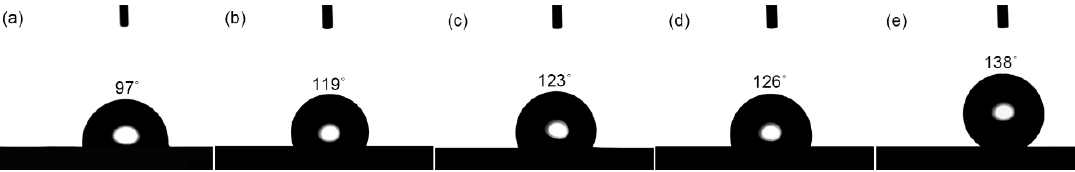
Figure 9. Contact angle of water on ( a ) raw jute fibers, jute fibers pretreated at 100 °C for ( b ) 3 and ( c ) 5 h, and jute fibers pretreated at 130 °C for ( d ) 3 and ( e ) 5 h.